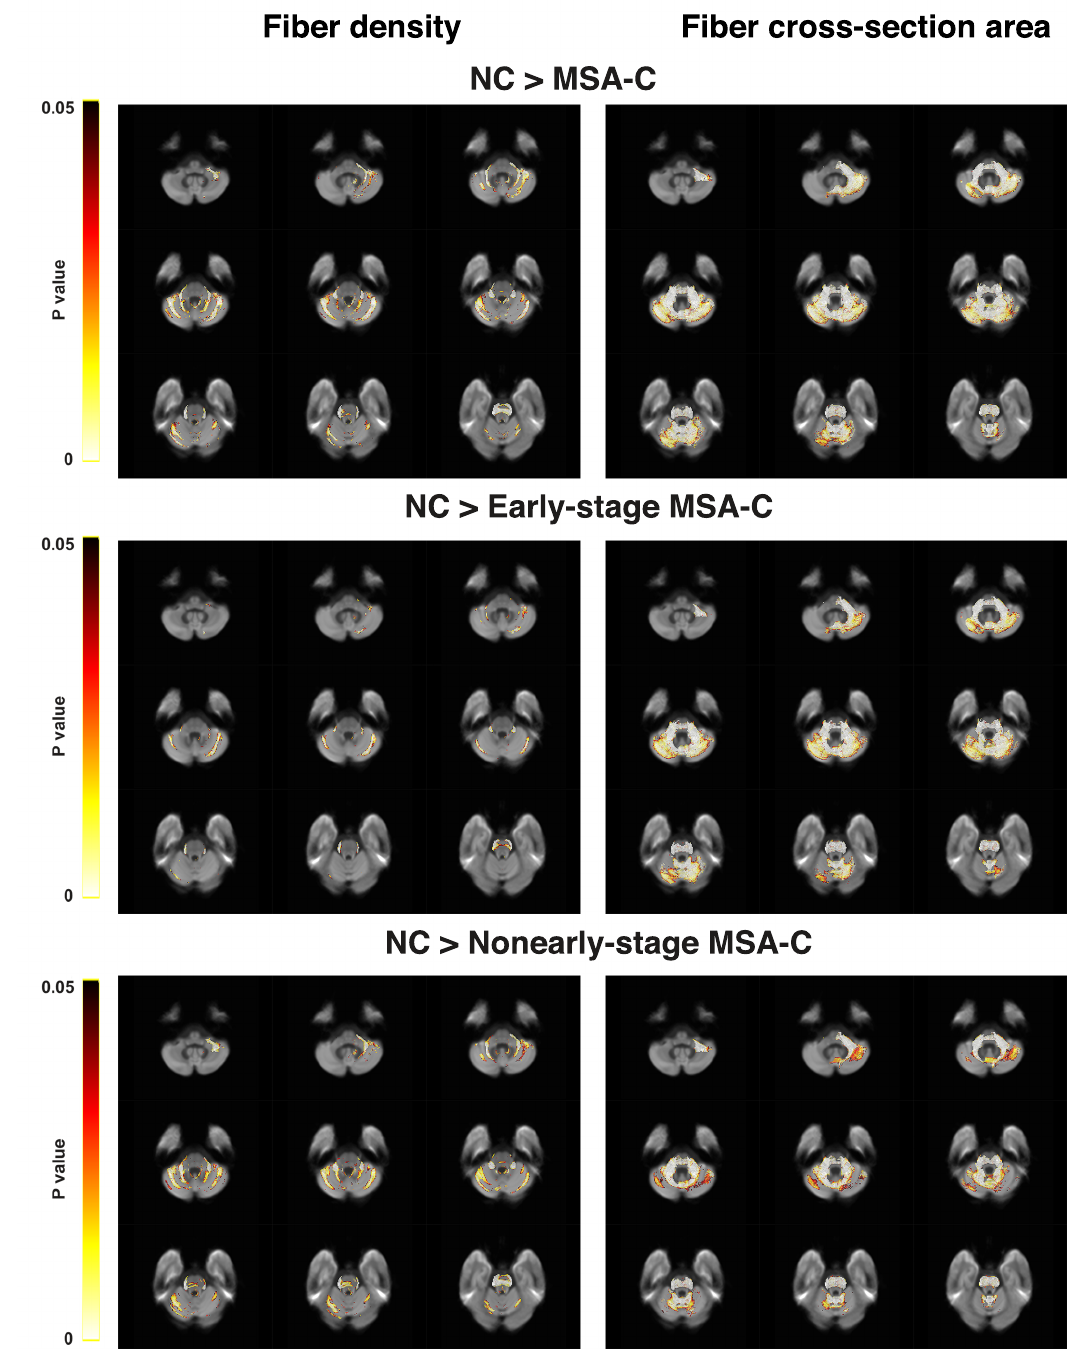
Fig. 4 Comparisons of fi ber density and bundle cross-sectional area between the MSA-C patients and normal controls. Indices of fi ber density and bundle cross-sectional area were derived using fi xel-based analysis described in Supplementary Material A. In each voxel location, p value is the average of the p values from all the fi xels it contains. p values of signi fi cant differences between the two groups are color coded and superimposed onto representative 2D anatomical slices. Panels from top to bottom show respectively the voxel locations with signi fi cant decrease ( P < 0.05, FWE corrected) in fi ber density (left column) and bundle cross-sectional area (right column) in all the MSA patients, early- and nonearly-stage patients relative to the controls. Radiologic view conventions are indicative of impaired communications in the WM bundles bundles were accompanied by alterations in the frequency involved. Metabolically, it has been found 38 that MSA-C patients domain of the functional signals. We found that the WM bundles in these patients exhibited qualitatively differences in PSD pro fi les, exhibited a reduced glucose uptake rate in the cerebellum, pons and these differences depended on the duration of the disease. and medulla, and a hypometabolism in the cerebellum and Taken together, the decreased functional connectivity and altered brainstem, along with prefrontal and cingulate cortices, for those spontaneous signal oscillations observed in this study are characterized by cerebellar and laryngeal-pharyngeal involvement